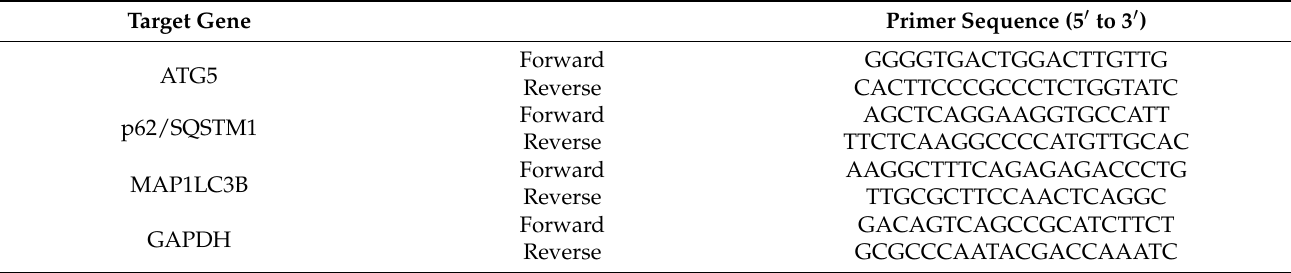
Table 1. Sequences of